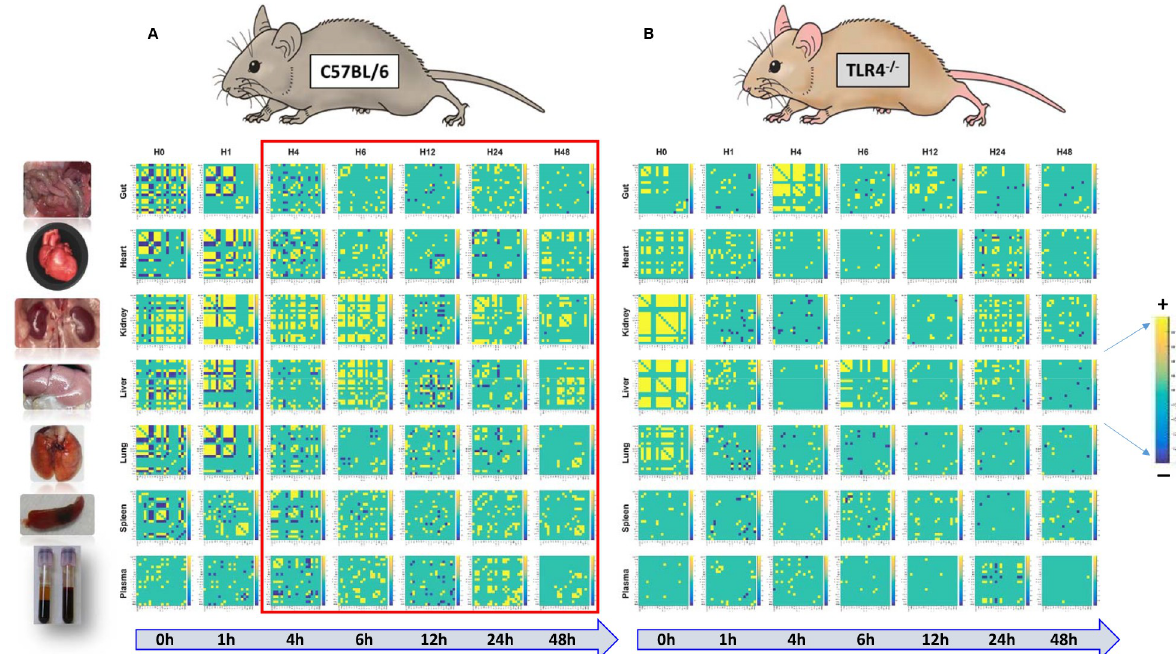
Fig 5. Pearson’s correlation between concentrations of inflammatory mediators in C57BL/6 and TLR4 -/- mice. Animals (C57BL/6, n = 5–8 and TLR4 -/- , n = 4 for each experimental group) were injected with LPS (3 mg/kg, i.p.). At different time points upon sacrifice, the inflammatory mediators in blood and different organs (liver, heart, gut, lung, spleen and kidney) were measured by Luminex and Pearson’s correlation was calculated as described in Materials and Methods . Figure shows the 20x20 correlation matrix of mediators’ interactions in all organs as well as in plasma for each time-point in C57BL/6 (Panel A ) and TLR4 -/- (Panel B ) mice. The time-point at which these results suggest the systemic spillover begins to occur in C57BL/6 mice is shown by a red box in Panel A .